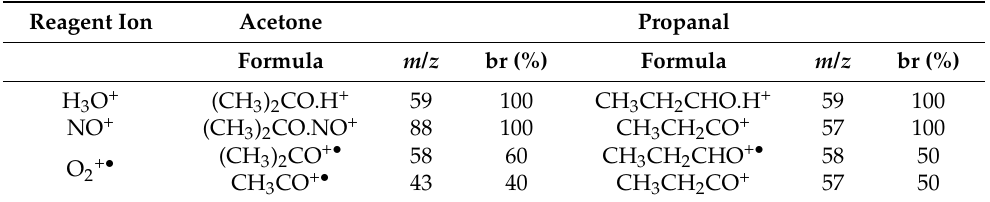
Table 3 ignores the so-called secondary chemistry of acetone and propanal—only the primary ions formed because of reagent ion reaction with the analytes are shown. These primary product ions can react with matrix species—most commonly water, though carbon dioxide is common for negative ions—to form secondary product ions [6,7]. Secondary reactions are commonly association reactions (Table 1), requiring that a third